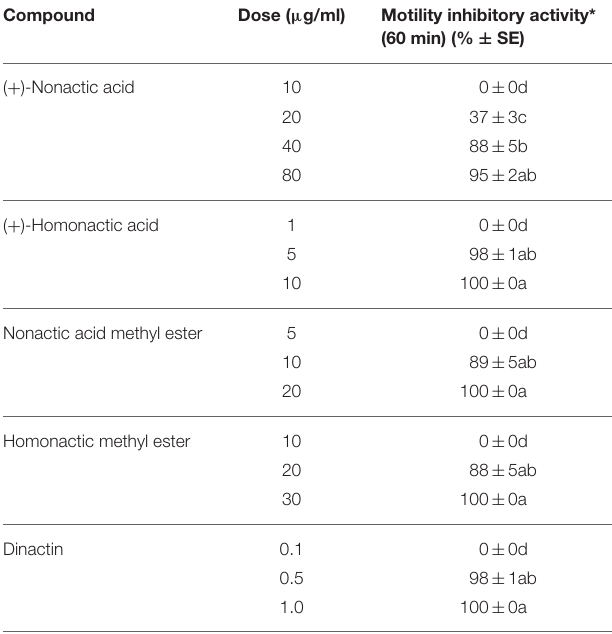
TABLE 4 | Motility inhibitory activity of nactic acids and their esters, and dinactin isolated from marine Streptomyces sp. Act 8970 against the sugar beet damping-off pathogen Aphanomyces cochlioides AC-1.